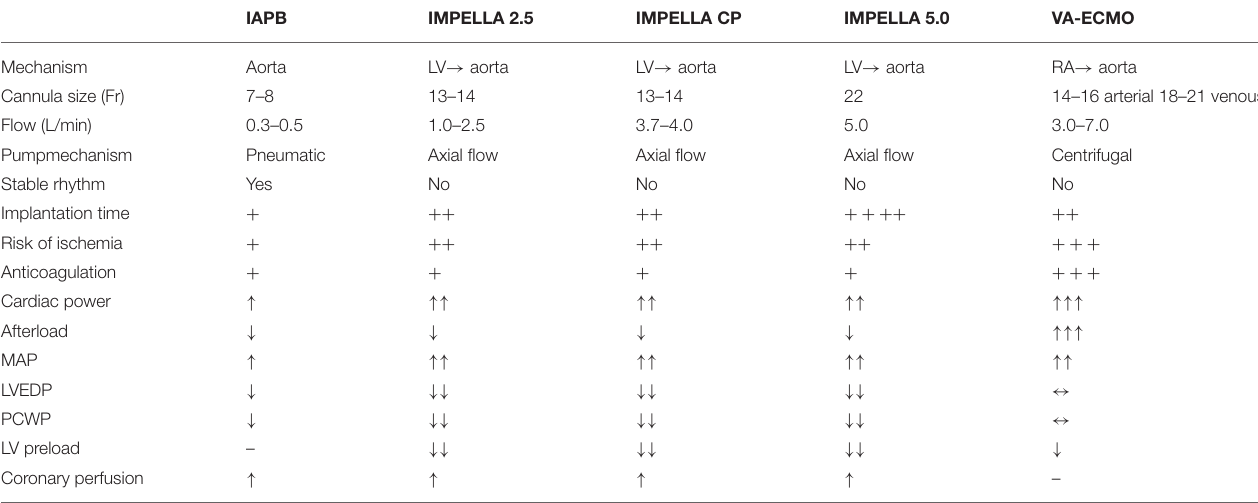
TABLE 3 | Technical properties of percutaneous circulatory assist devices.